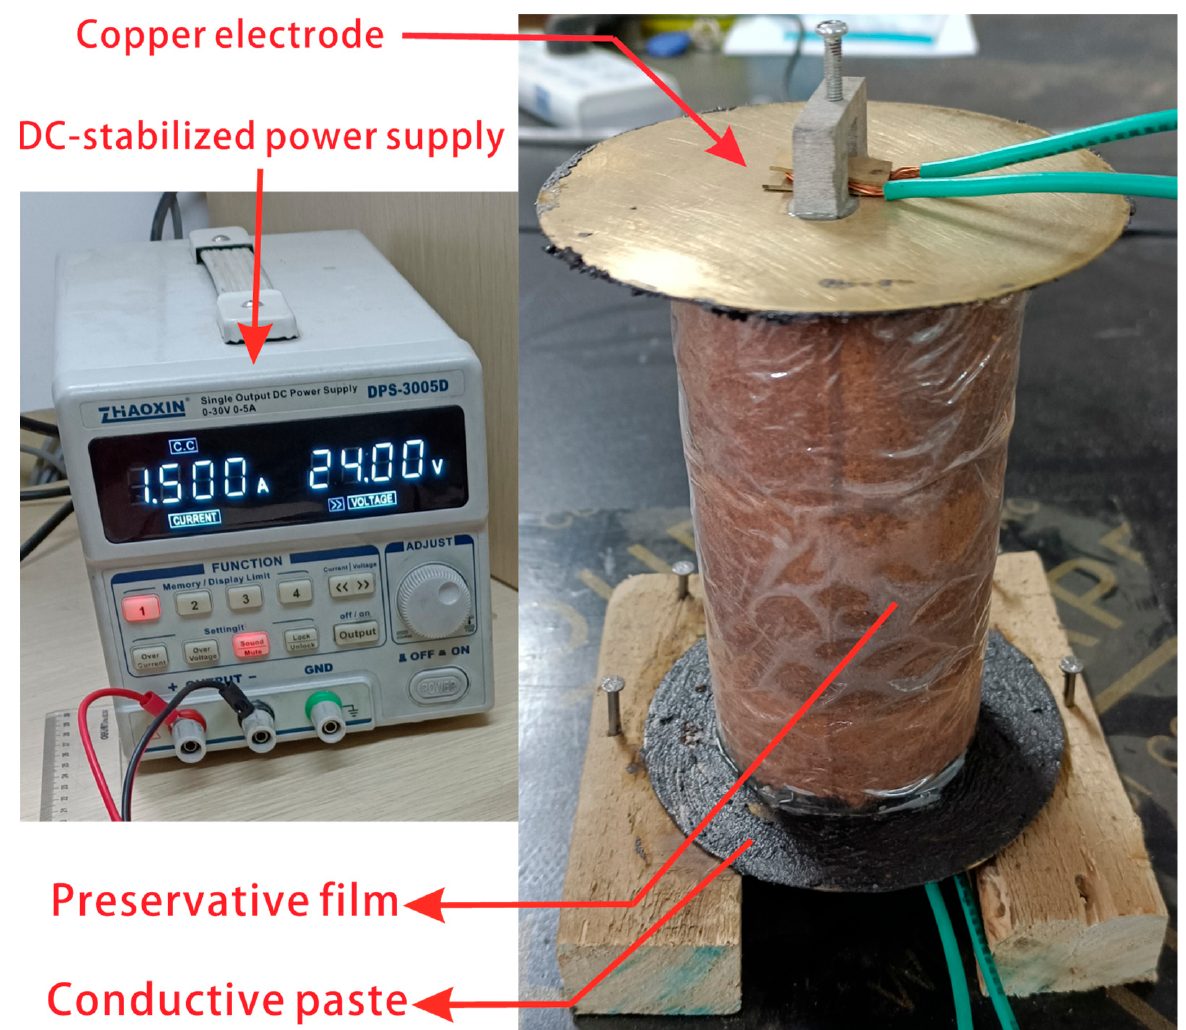
Figure 2. Soil resistivity test with the two-electrode method.